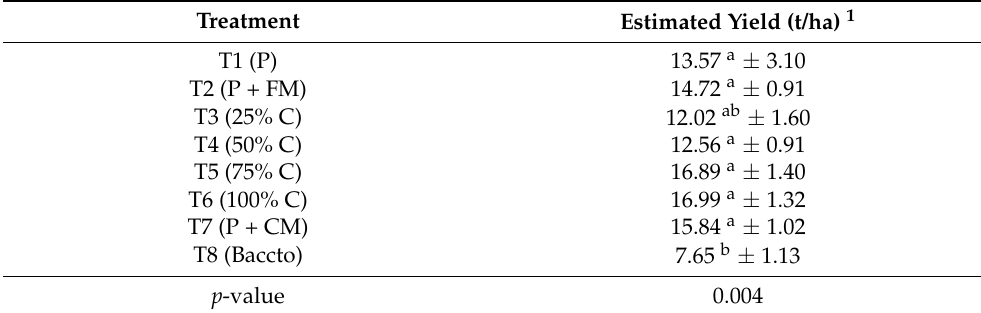
Table 7. Estimated yield of beets in metric ton per hectare, based on the total root weight per sample and the plot size ( n =